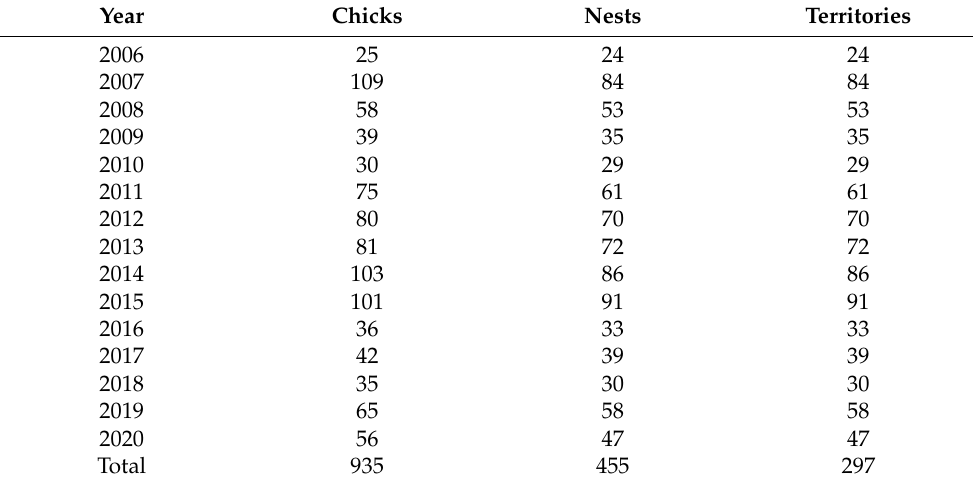
Table 1. Number of sampled chicks, nests, and territories during years 2006–2020 where samples were collected. Same territories were sampled in different years, and different nests from the same territories were sampled in different years, resulting in a different total number of nests and territories. Chicks Nests